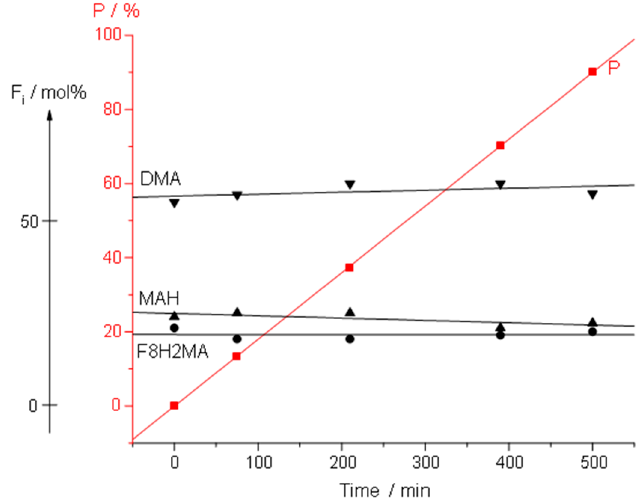
Figure 8. Change of the composition of C3 (P[F8H2MA- co -DMA- co -MAH]) terpolymer in time in continuous addition experiment. P, conversion; F, copolymer composition; MAH, maleic anhydride; DMA, dodecyl methacrylate; F8H2MA, 1 H ,1 H ,2 H ,2 H -perfluorodecyl methacrylate.